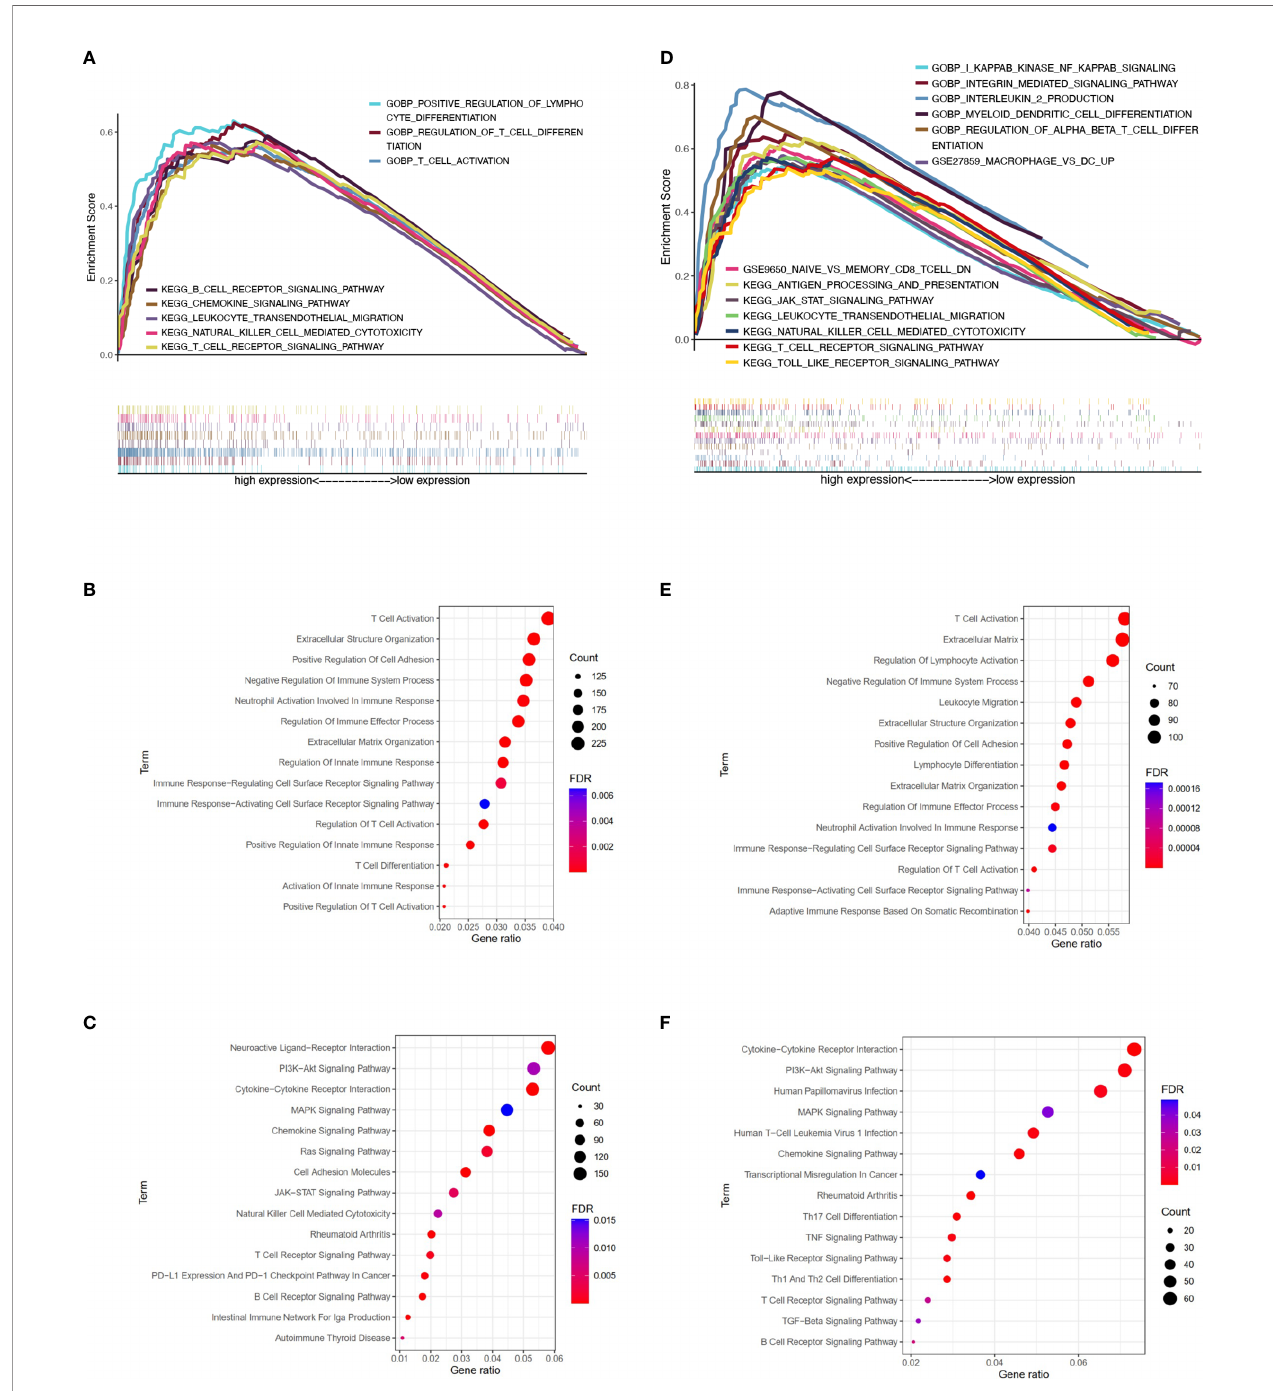
FIGURE 4 | Pathway enrichment analysis of patients with different ERAP2 expression level in SqCLC public data. (A) Enrichment analysis based on TCGA SqCLC data. Upper: pathways, terms, or gene sets enriched in ERAP2 high expression group. (B) Representative GO terms and pathways enriched in DEGs between high and low ERAP2 expression groups based on TCGA SqCLC data. (C) Representative KEGG terms and pathways enriched in DEGs between high and low ERAP2 expression groups based on TCGA SqCLC data. (D) Enrichment analysis based on GEO SqCLC data. Upper: pathways, terms, or gene sets enriched in ERAP2 high expression group. (E) Representative GO terms and pathways enriched in DEGs between high and low ERAP2 expression groups based on GEO SqCLC data. (F) Representative KEGG terms and pathways enriched in DEGs between high and low ERAP2 expression groups based on GEO SqCLC